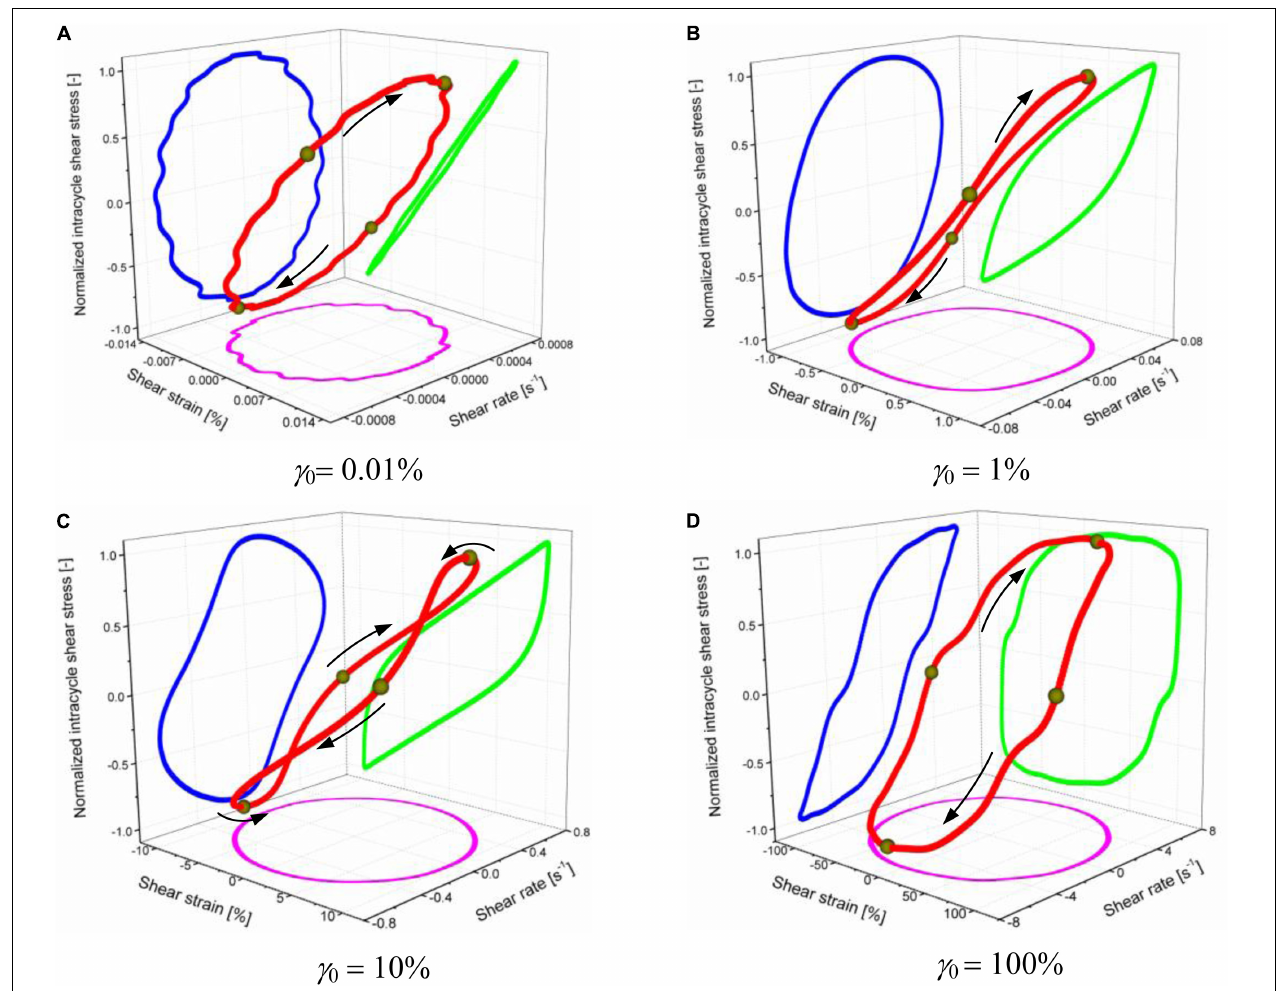
FIGURE 4 | Three-dimensional normalized intracycle stress response of MRG-70 under different shear strain amplitudes, i.e., (A) 0.01%, (B) 1%, (C) 10%, and (D) 100%. The frequency f was always kept at 1 Hz. The external magnetic field was set as 391